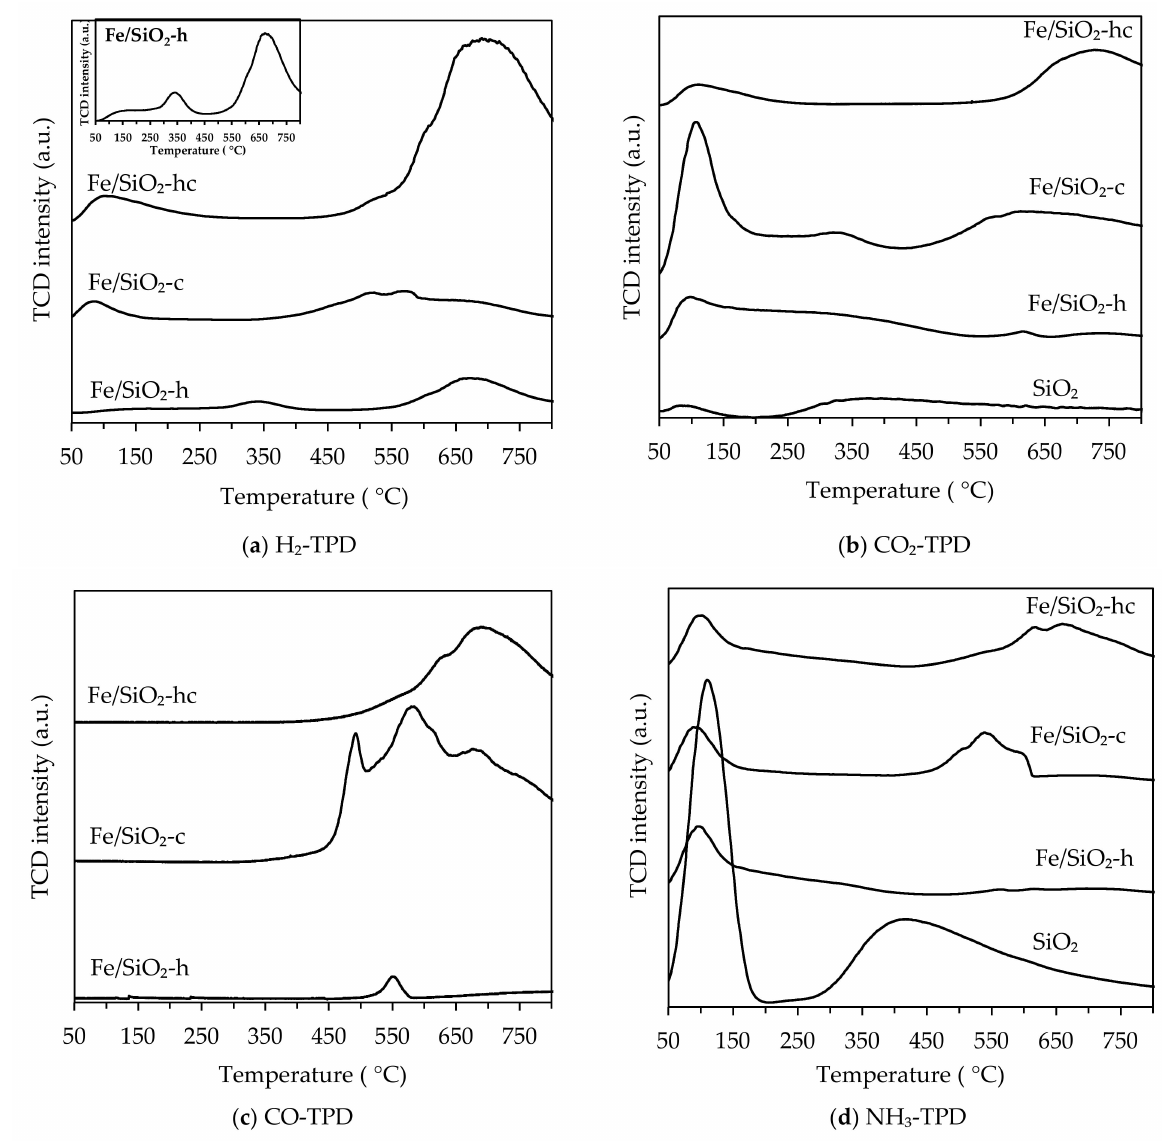
Figure 4. ( a ) H 2 -TPD profiles, ( b ) CO 2 -TPD profiles, ( c ) CO-TPD profiles, and ( d ) NH 3 -TPD profiles of Fe/SiO 2 -h, Fe/SiO 2 -c and Fe/SiO 2 -hc